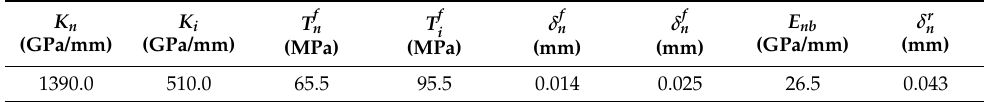
Table 5. Experimental results of indentation depth rebound with time.